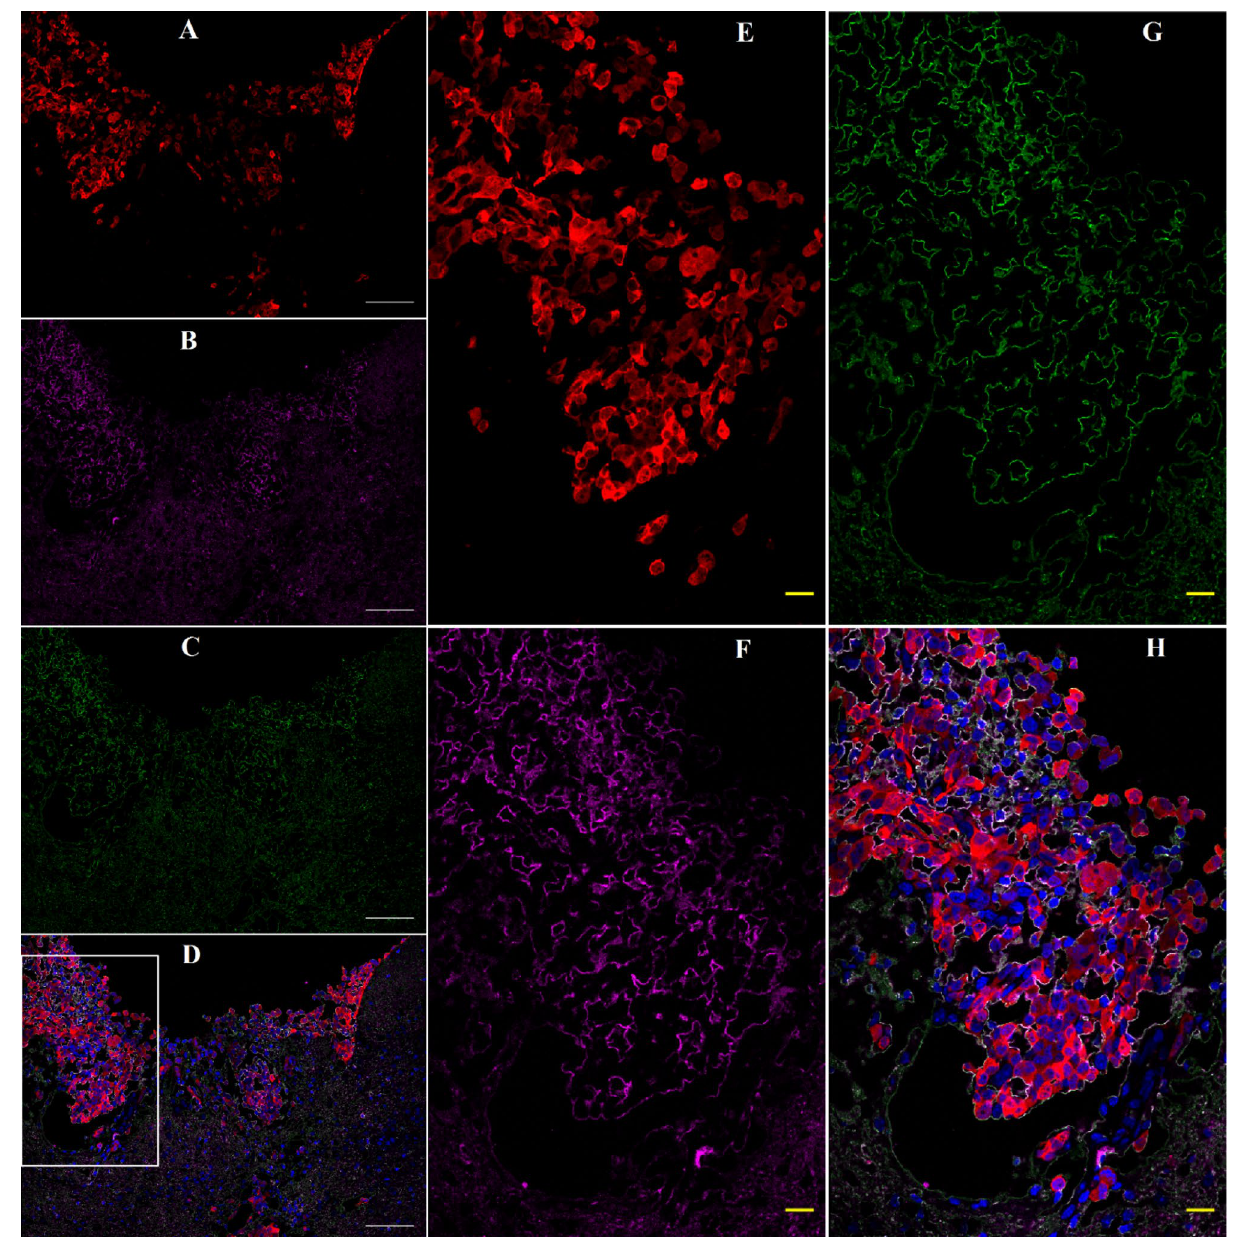
Figure 7. Confocal images (63 ×) of mouse brain with an advanced 231TL tumor 24 h after iv INP injection: Colocalization of INPs and Collagen I. Immunofluorescence was performed as described in Methods. Panels A – D are low power images; E – H higher power images of the boxed region in panel D . tDTomato = tumor cells; Green = INP; Magenta = Collagen 1; Blue = Dapi (Nuclei). White inset in figure D is enlarged in E–H. White bar = 100 µm; Yellow bar = 20